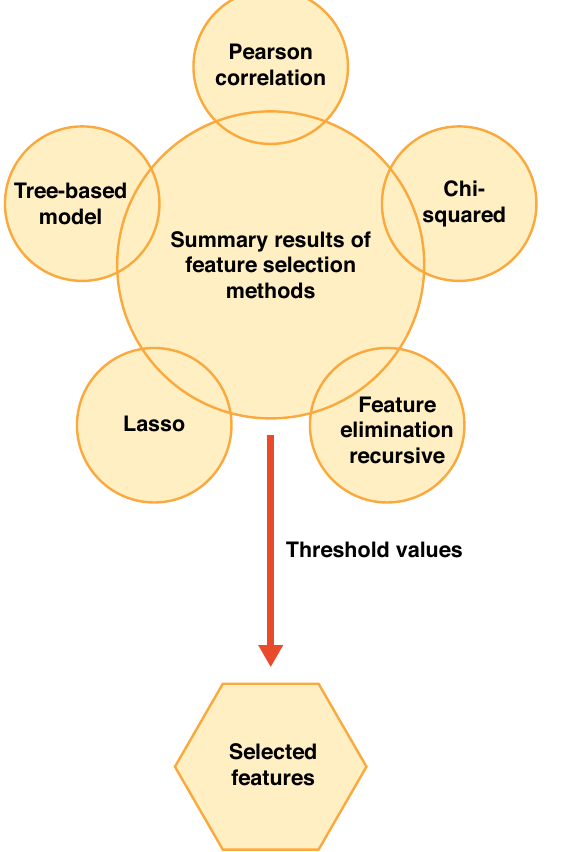
Figure 1. Feature selection strategy prior to model training.